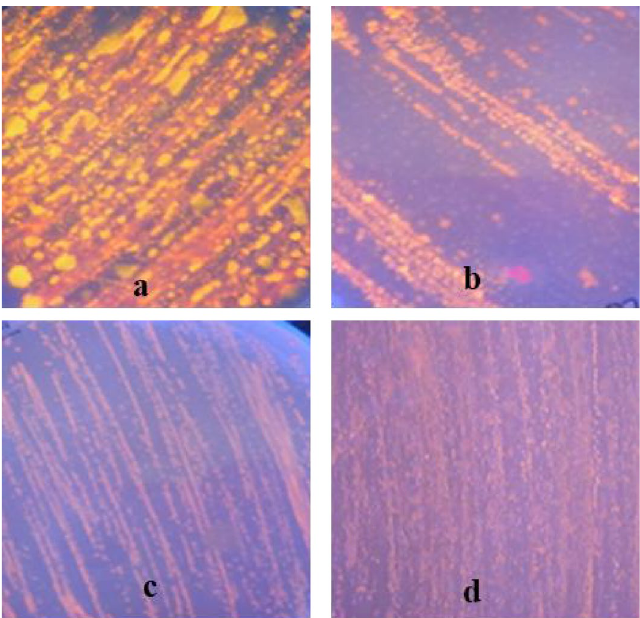
Figure 5. Lipase expression on LB agar plus olive oil and IPTG plates. ( a ) Pseudomonas sp. KE38 as a positive control. ( b ) E. coli BL21(DE3) pET28a-LipI.3_KE38. ( c , d ) E. coli BL21(DE3) and E. coli BL21(DE3) pET28a as negative controls, respectively. Positive control P. fluorescens KE38 and E. coli BL21(DE3) pET28a-LipI.3_KE38 produced the lipase enzyme, which split the substrate olive oil resulting in the formation of fluorescence orange halos around colonies proved that activity. There was no fluorescence around the colonies of the negative controls, E. coli BL21(DE3) and E. coli BL21(DE3) pET28a as expected. Plates were incubated at 25